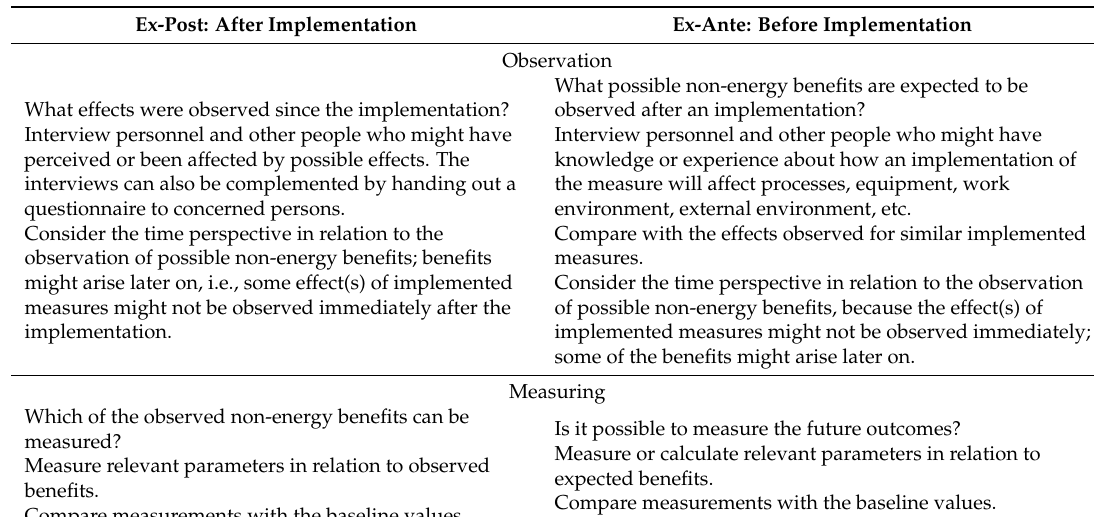
Table 7. A guiding scheme for the improved utilisation of industrial non-energy